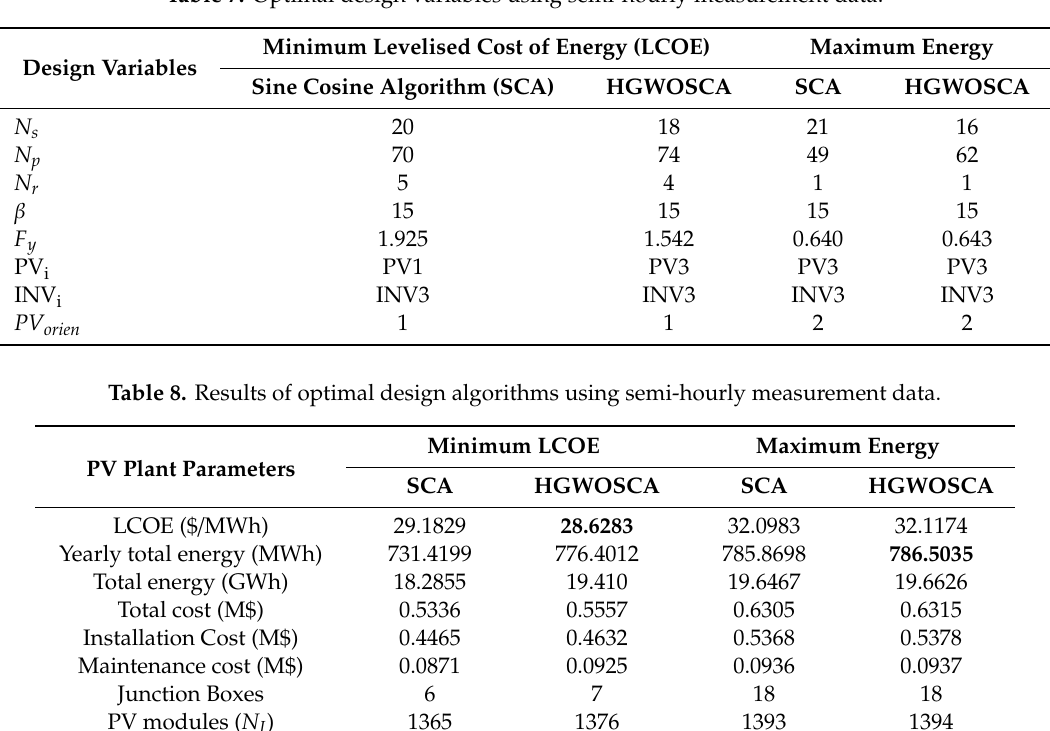
Table 8. The optimisation process applying HGWOSCA outperforms the single SCA for minimum and maximum objective functions. Table 7. Optimal design variables using semi-hourly measurement data.